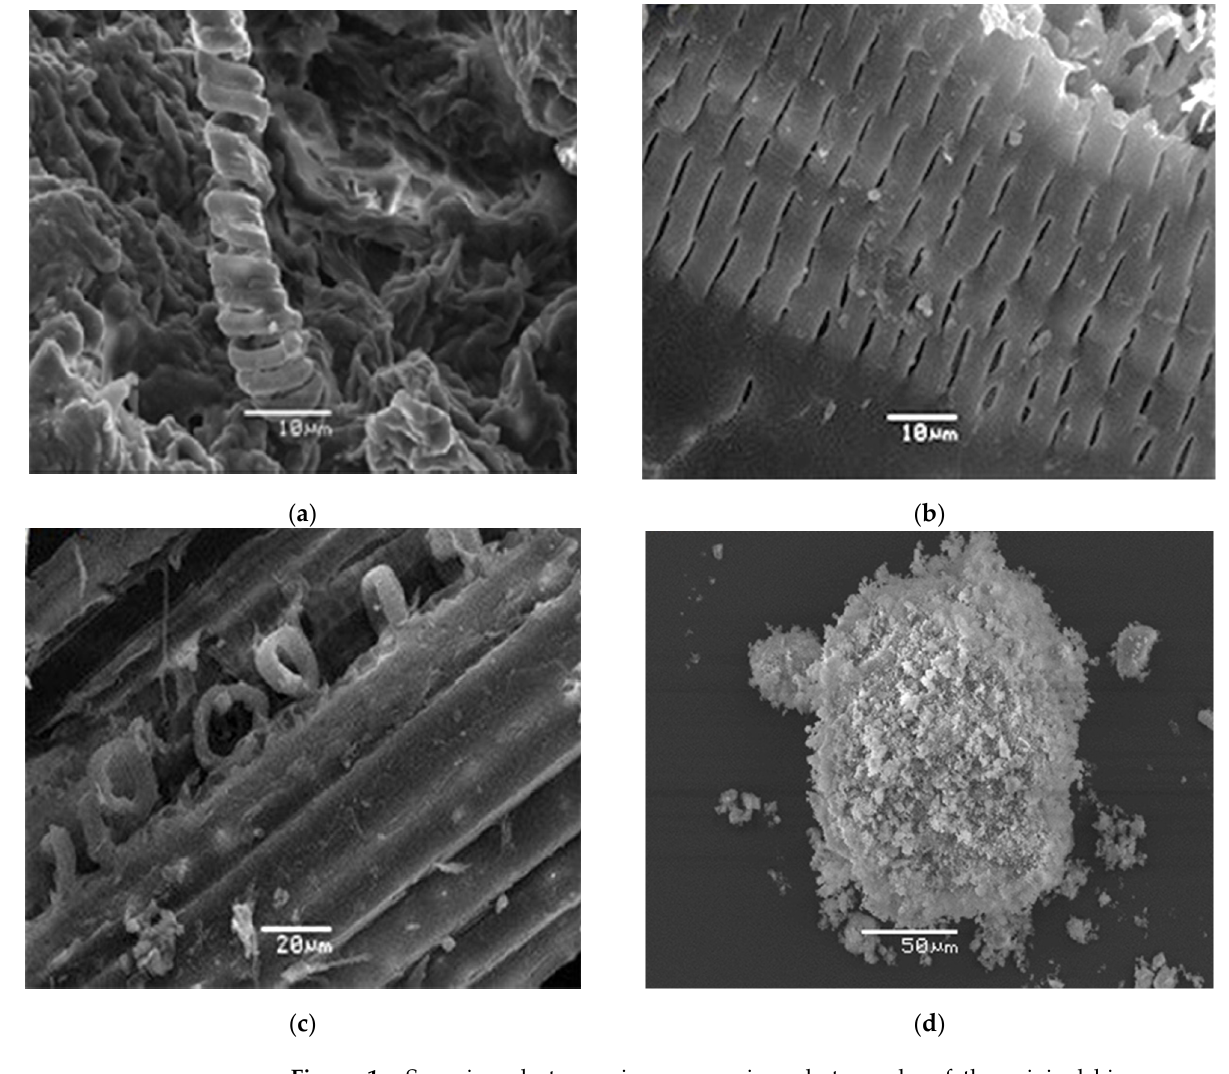
Figure 1. Scanning electron microscope micro ‐ photographs of the original biomass samples: ( a ) lignocellulosic fibers in olive kernel residues biomass, ( b ) vegetal porous structure in reed biomass, ( c ) fiber structures in reed biomass, ( d ) arcanite spherical agglomerate in reed biomass ash.